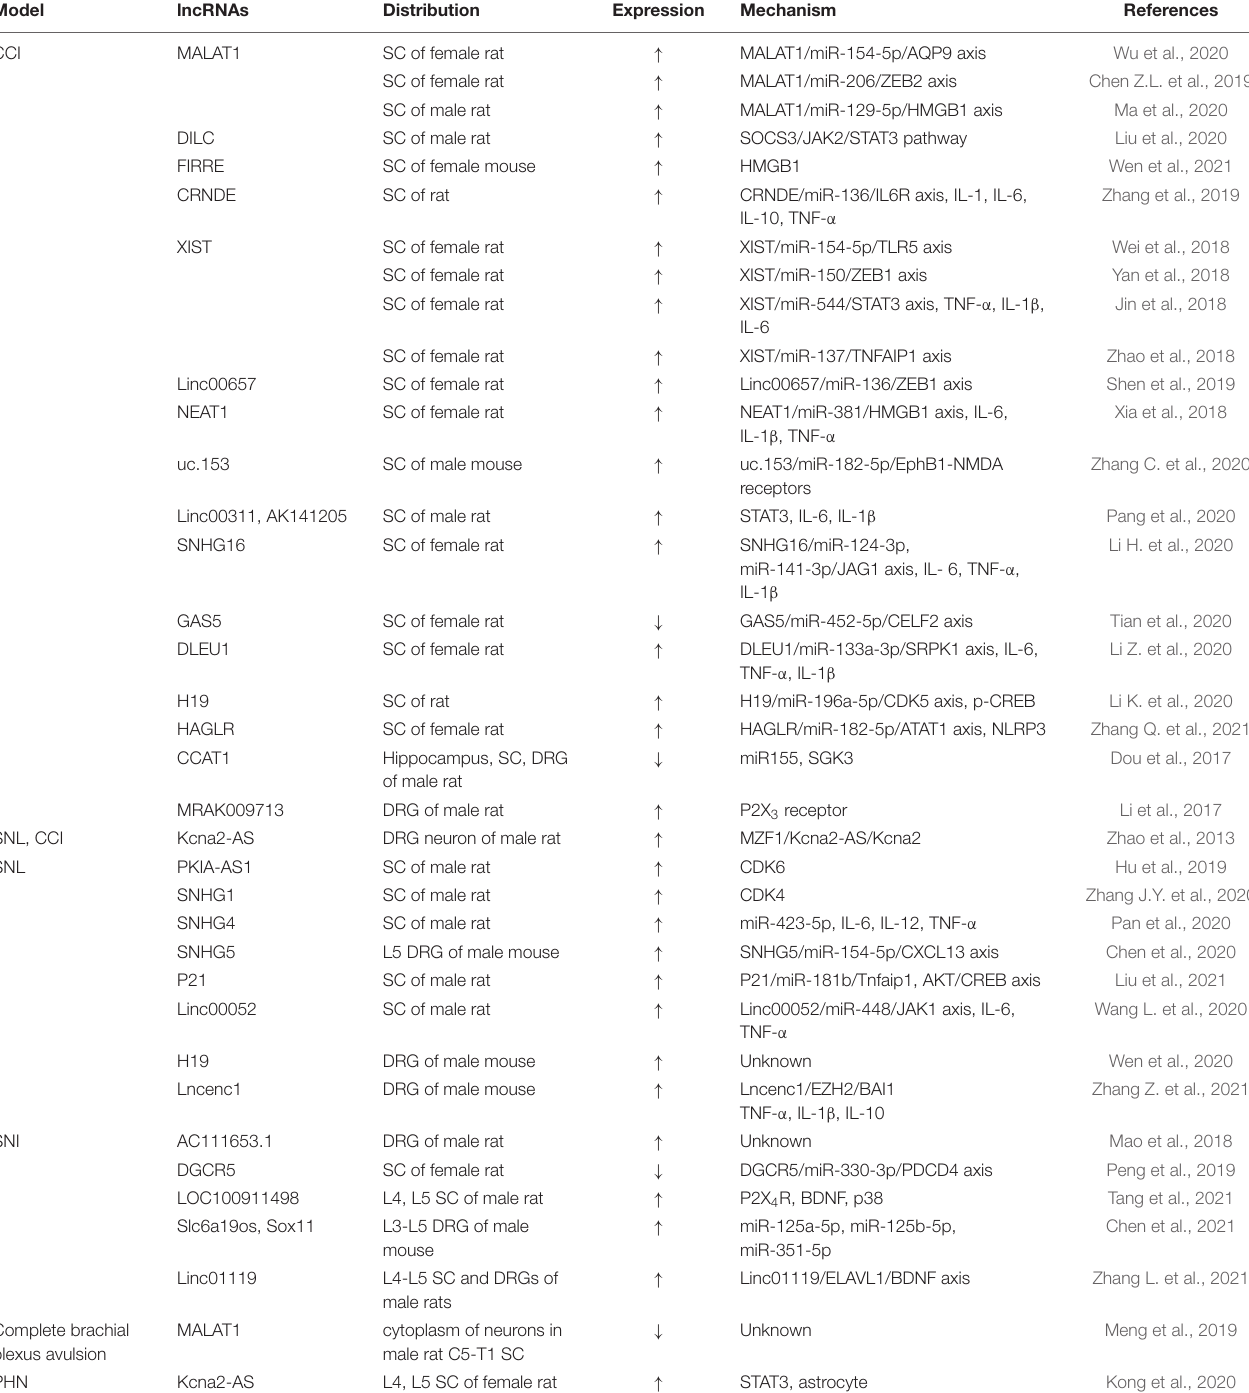
TABLE 1 | lncRNAs and peripheral nerve